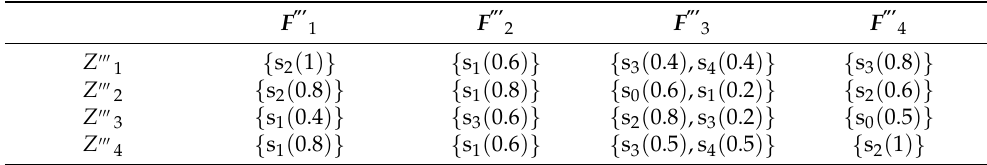
Table 6. Evaluation information of investment projects.